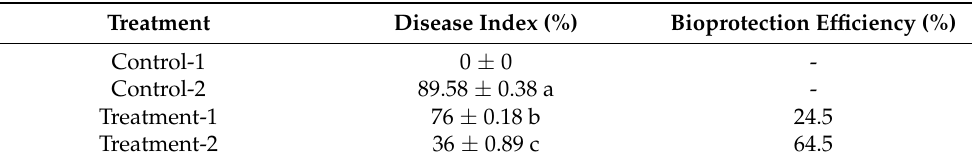
Table 3. Bioprotection efficiency of PGPB strains against wheat fungal wilt caused by Fusarium graminearum Schwabe